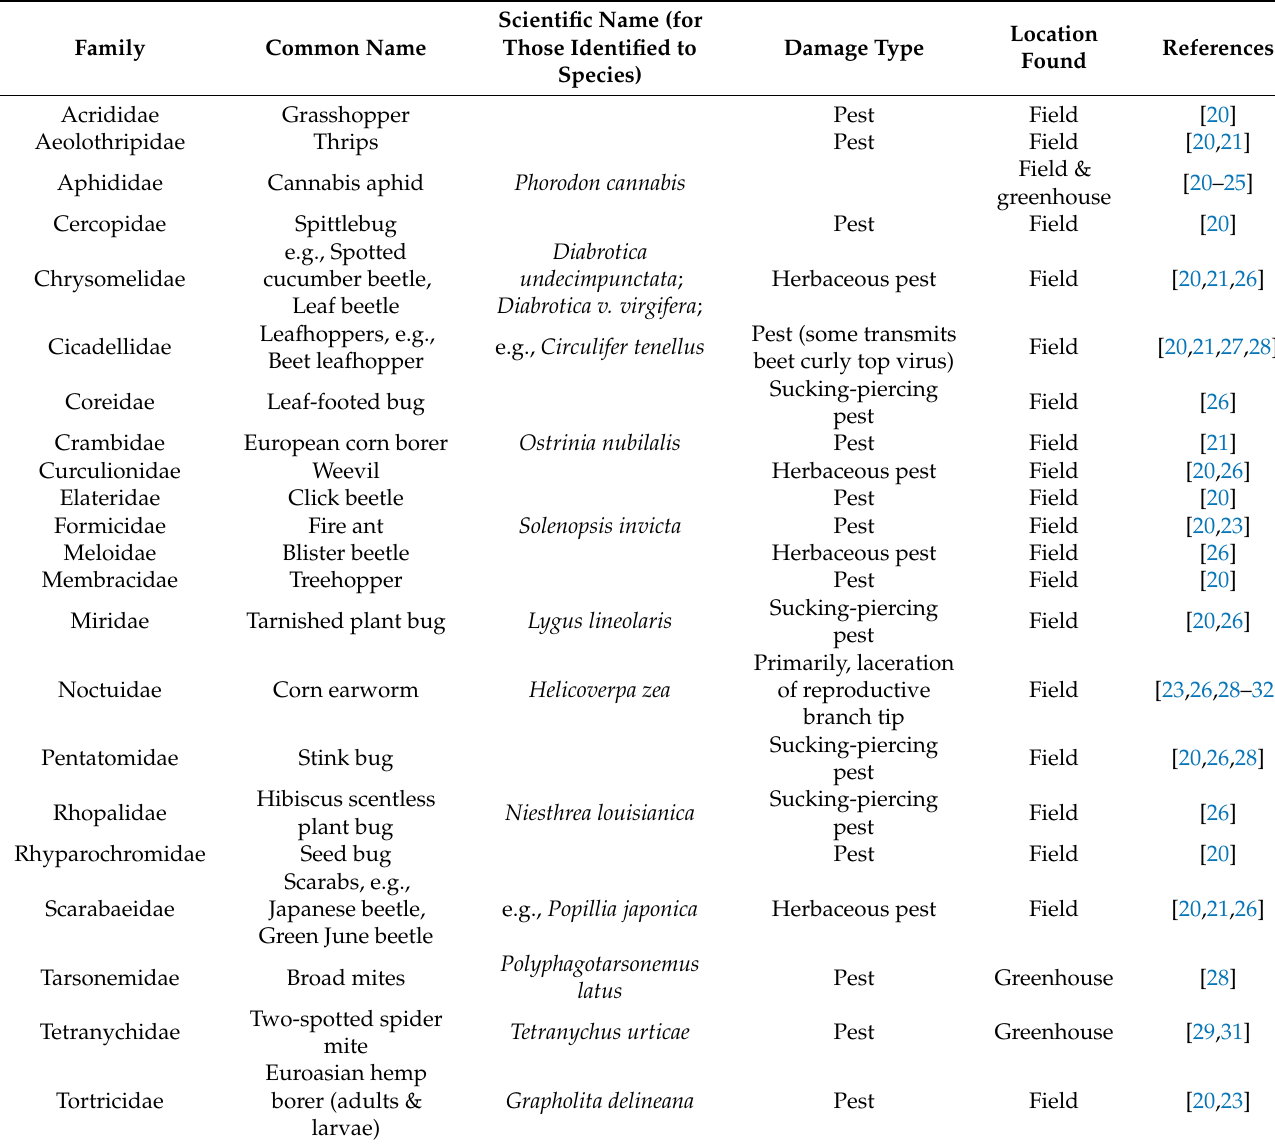
Table 1. A list of some pest arthropods reported on hemp in the United States.